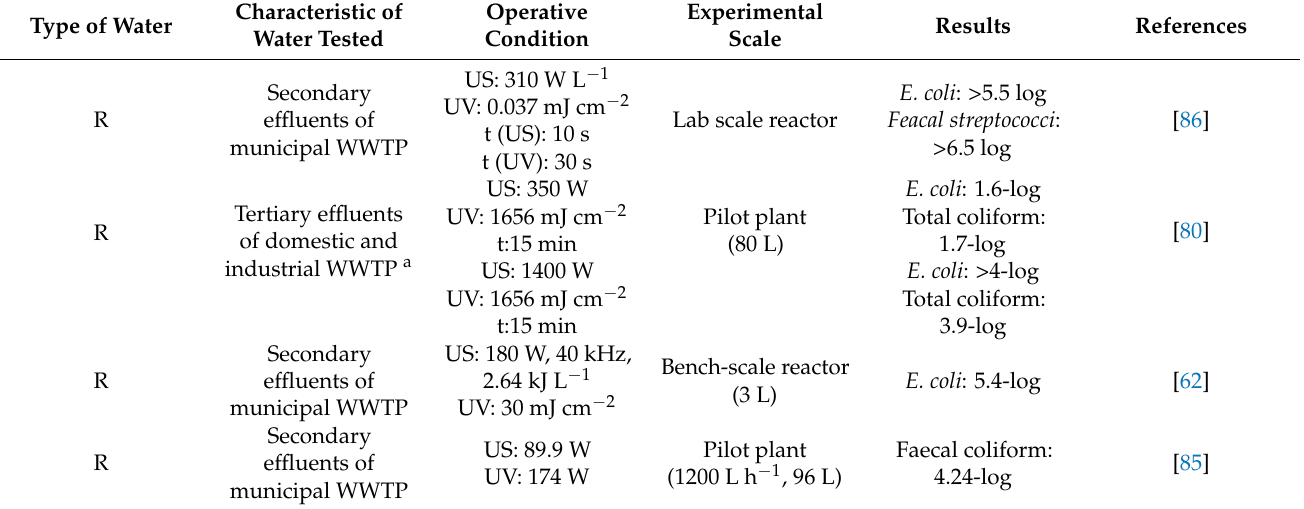
Table 3. Several results of sonophotolysis disinfection tests. S: synthetic water, R: real water, UV: ultraviolet radiation, US: ultrasound, t: contact time. Type of